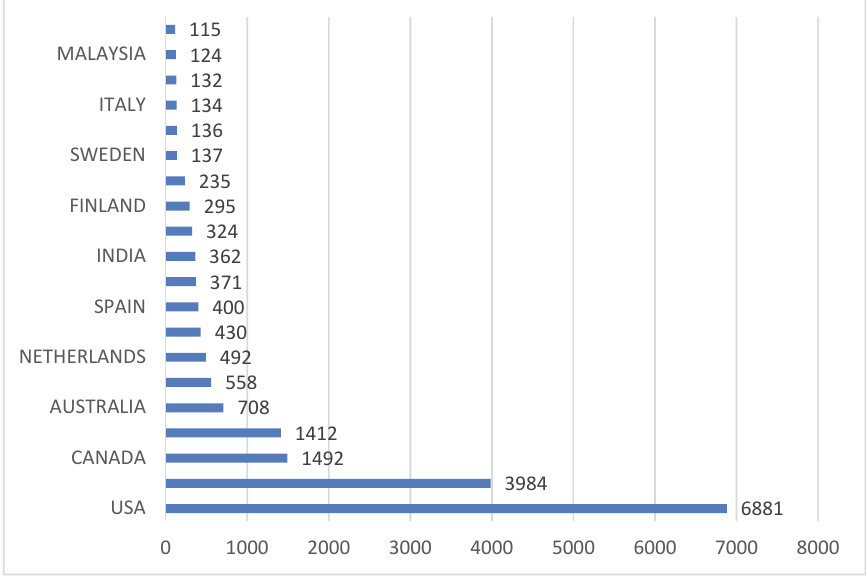
Fig. 5. Most Cited